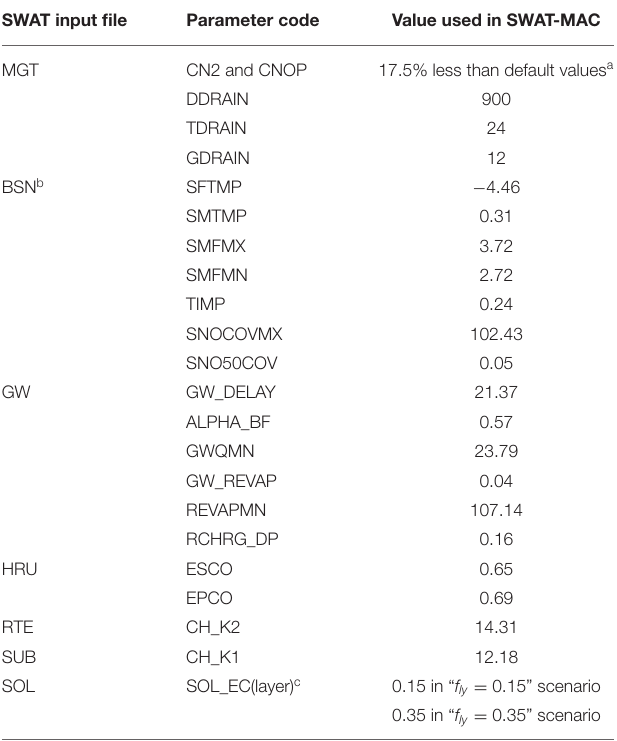
TABLE 2 | Parameter values used in SWAT-MAC, taken from the unmodified SWAT after it was calibrated for the Ewing subwatershed of the Pike River watershed, southern Quebec,